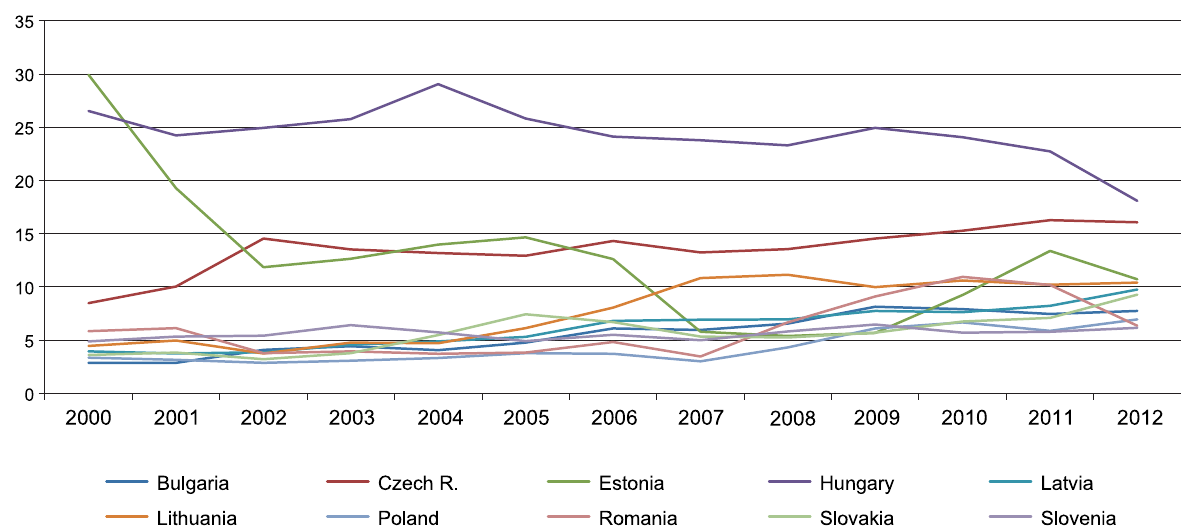
Table 6. Summary measures of the commodity concentration of exports and imports in the post-communist countries and the EU in 2000 and 2012.